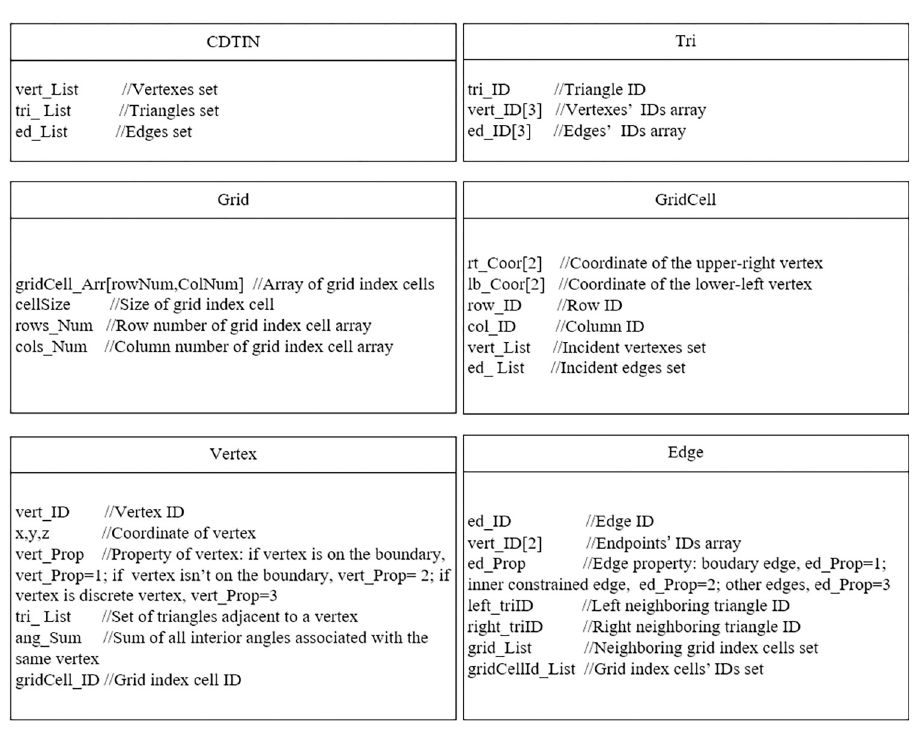
Fig 1. Data structure of the